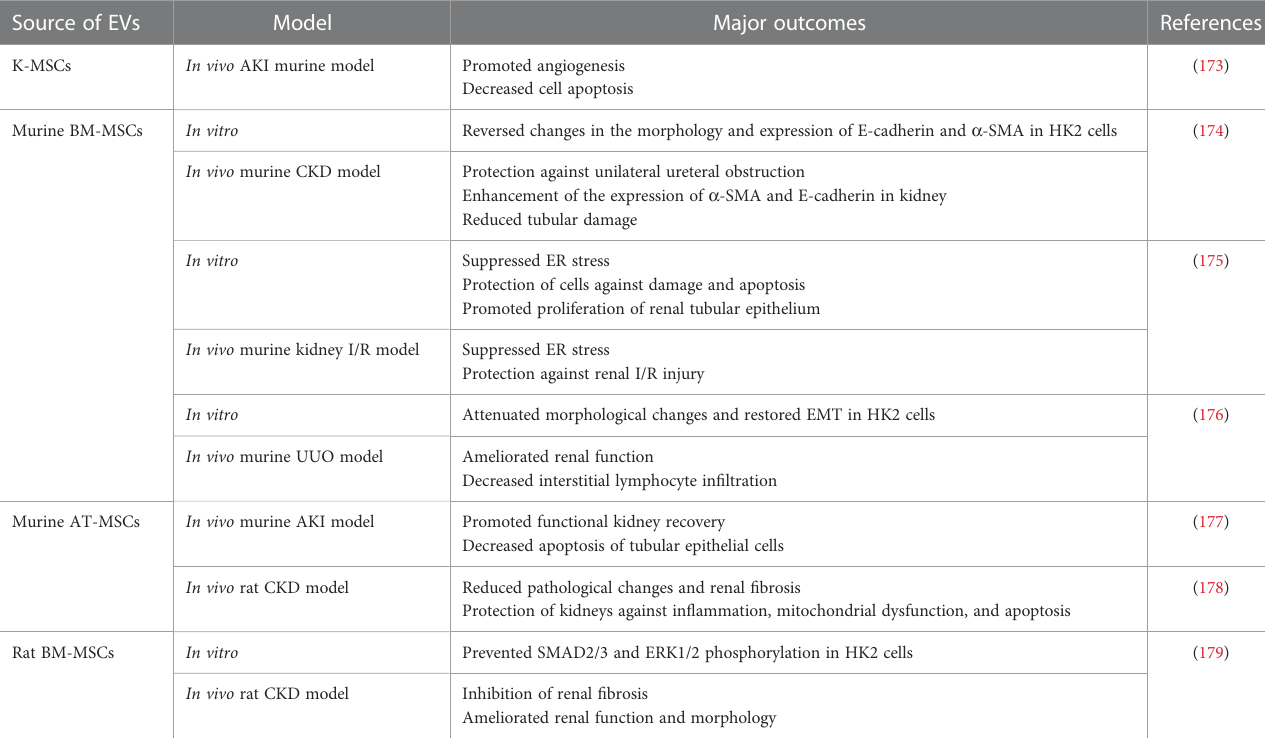
TABLE 3 Examples of EV use in preclinical studies related to the treatment of kidney diseases. Source of